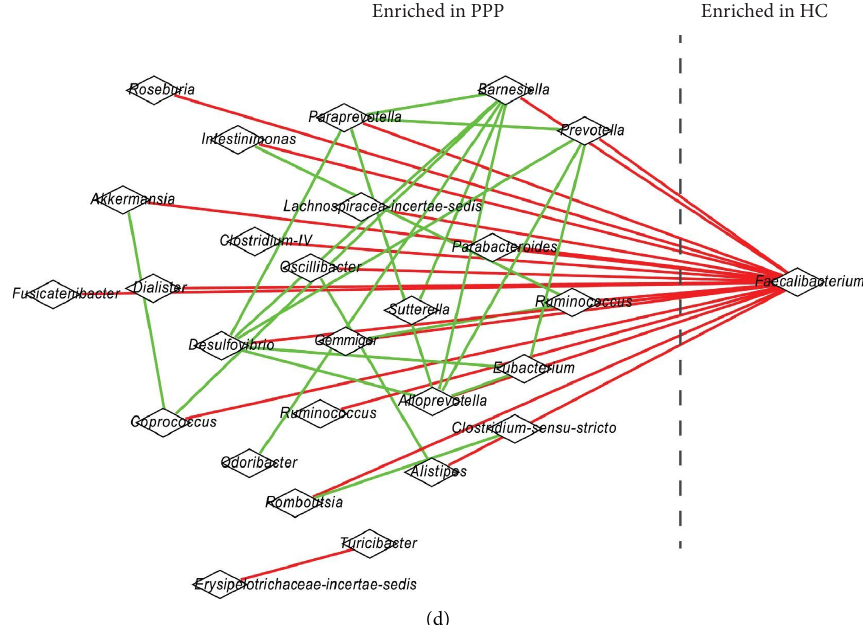
Figure 2: Te diferences of top abundant genera between the ICPP/PPP and HC groups, and the co-occurrence network of the genera. Te abundances of genera were compared between the ICPP (a) or PPP (c) and HC group. Te asterisks indicated the P -values. ∗ , ∗∗ , ∗∗∗ , and ∗∗∗∗ stand for the P -value smaller than 0.05, 0.01, 0.001, and 0.0001, respectively. Te genera enriched in the ICPP and HC groups (b), and the PPP and HC groups (d) were selected. Teir co-occurrence networks were constructed. Te green and red edges suggest the positive and negative correlations, respectively.